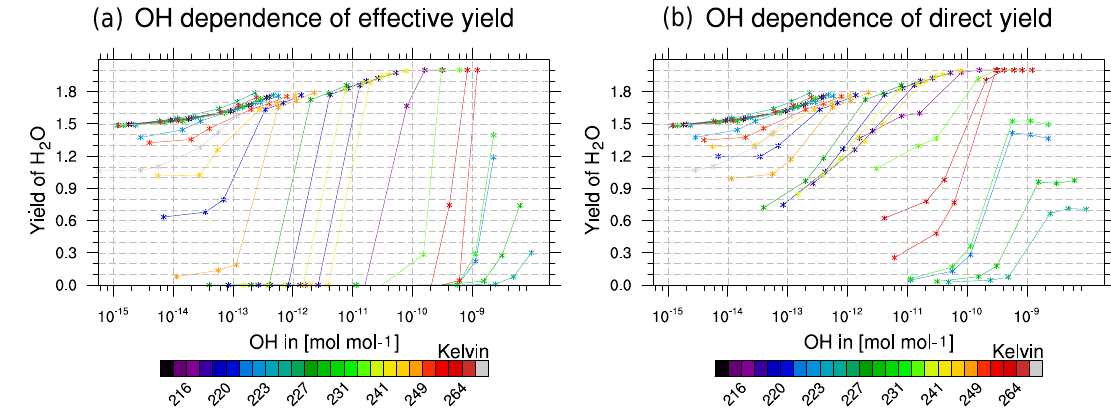
Figure 8. Effective yield (a) and direct yield (b) versus OH; colors indicate temperature from low to high